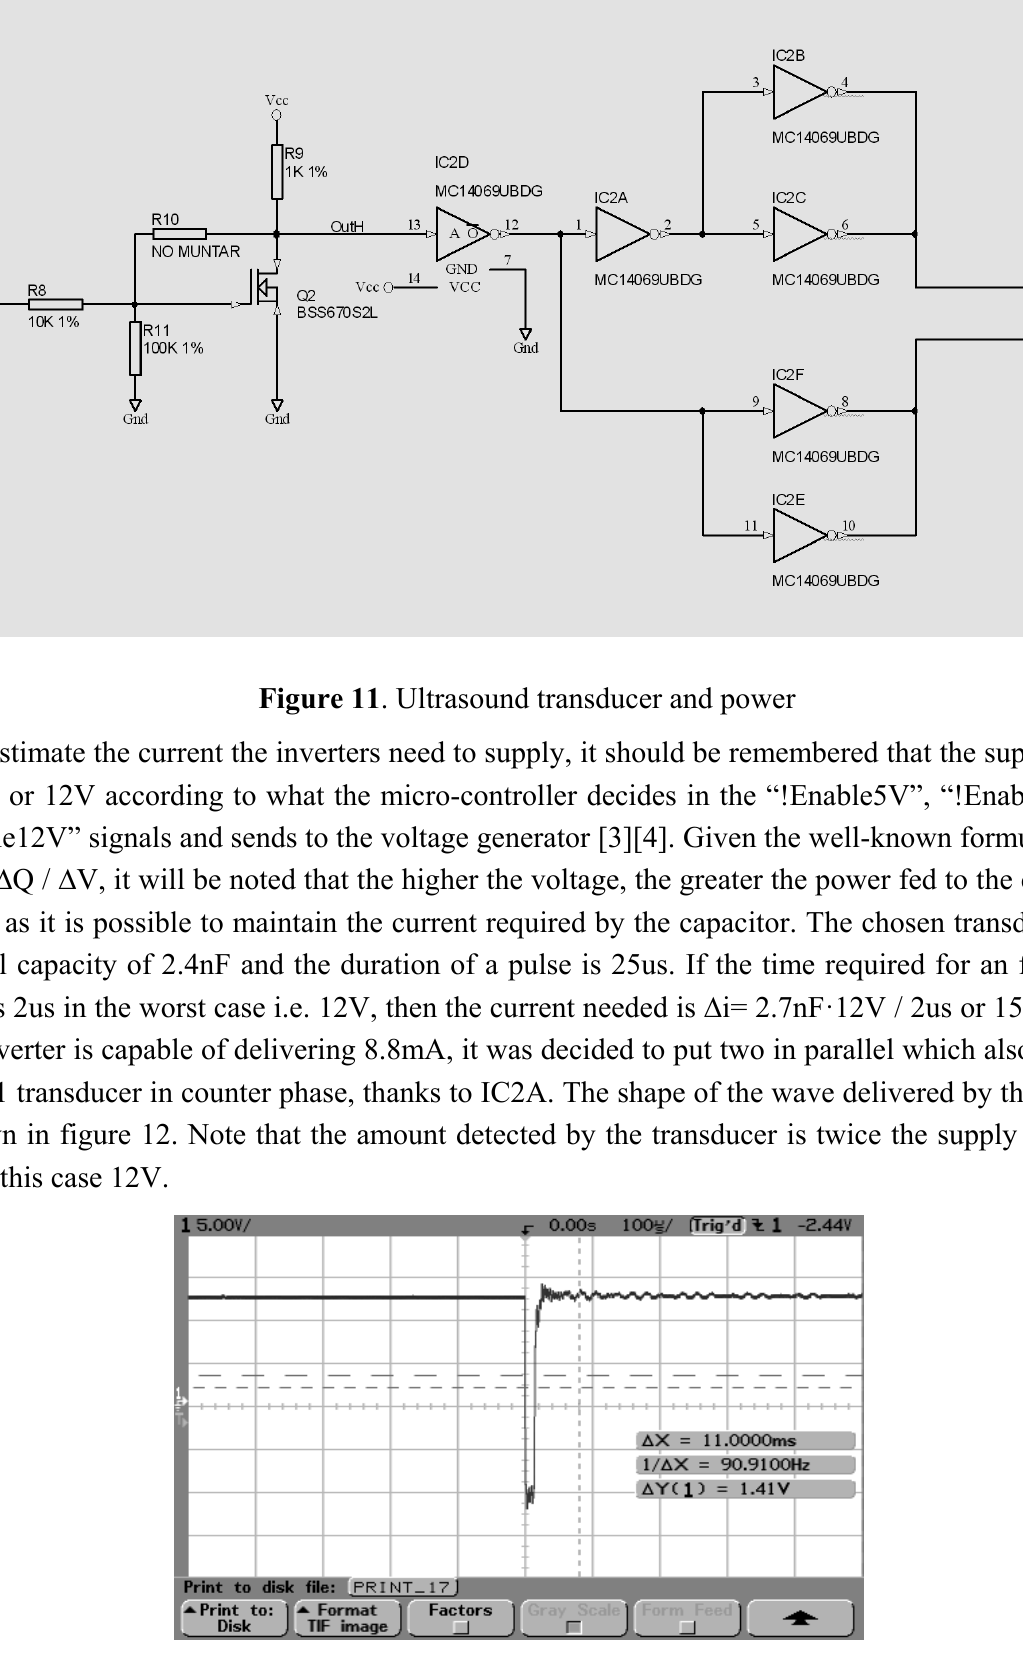
Figure 12 . Ultrasound transducer waveform